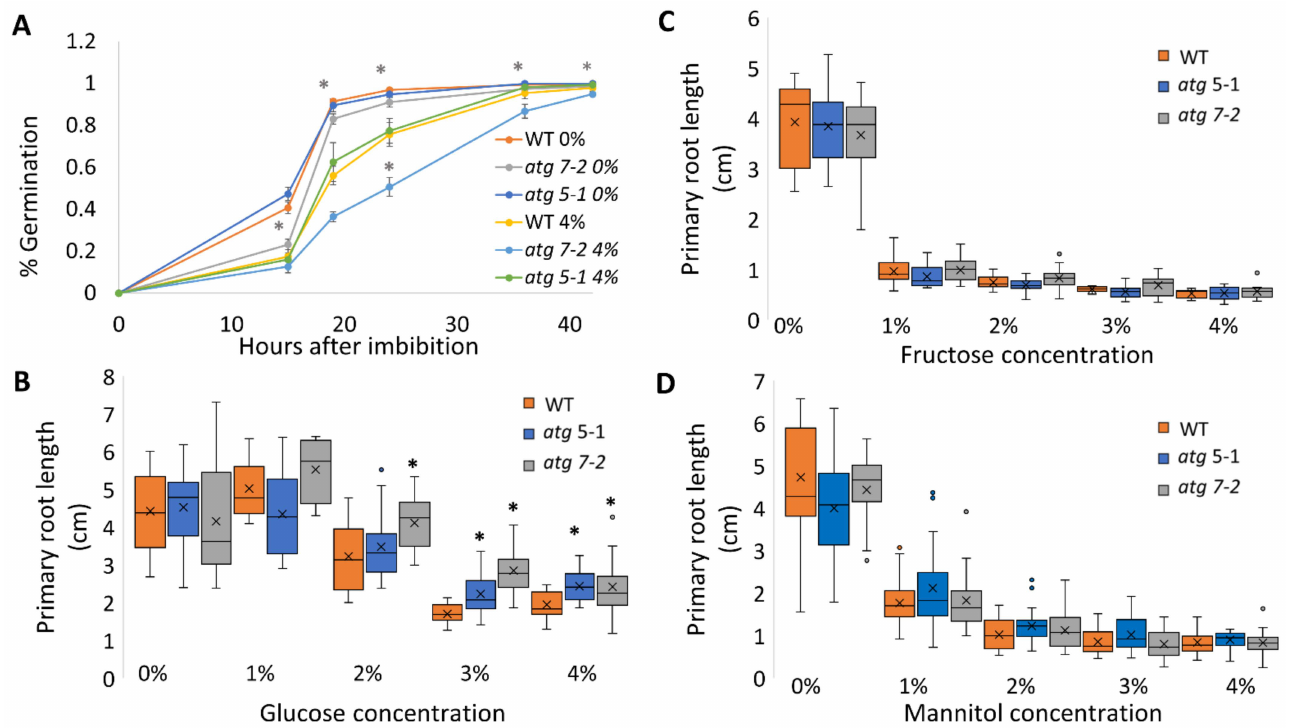
Figure 2. Less root length inhibition in atg mutants under sucrose and glucose but not fructose. WT, atg5-1 , and atg7-2 plants were sown on Nitsch plates containing increasing concentrations of sugars (molar equivalent to sucrose concentration). ( A ) Germination percentage (GP) of WT, atg5-1 , and atg7-2 seeds under 0% and 4% sucrose. Data are presented as the average ± SE. An asterisk denotes a significant difference from WT under the same treatment conditions and at the same time point, as determined by Dunnett’s test ( p < 0.05, n = 4–6); light grey— atg5-1 , dark grey— atg7-2 . ( B ) Quantification of primary root length under various glucose treatment conditions. An asterisk denotes a significant difference from WT under the same treatment by Dunnett’s test ( p < 0.05, n = 8–24). x indicates sample mean, and circles denote outliers. ( C ) Quantification of primary root length under various fructose concentrations. No significant difference from WT under the same treatment condition was found by Dunnett’s test ( p < 0.05, n = 9–17). x indicates sample mean, and circles denote outliers. ( D ) Quantification of primary root length under various mannitol treatments. No significant difference from WT under the same treatment condition was found by Dunnett’s test ( p < 0.05, n = 16–22). x indicates sample mean, and circles denote